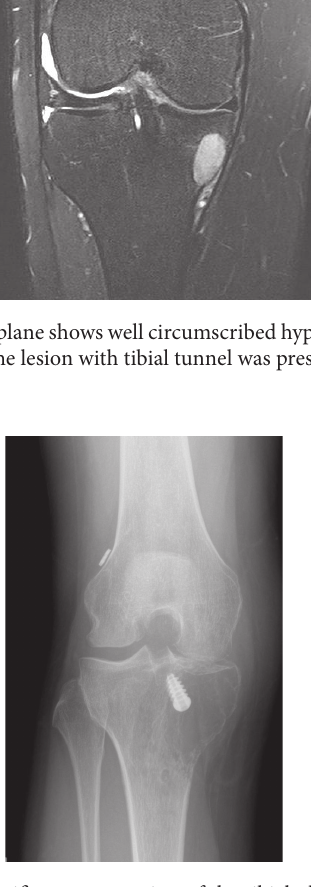
Figure 6: AP radiograph of the right knee shows significant progression of the tibial plateau osteolytic lesion in the medial tibial plateau, which now extends to the